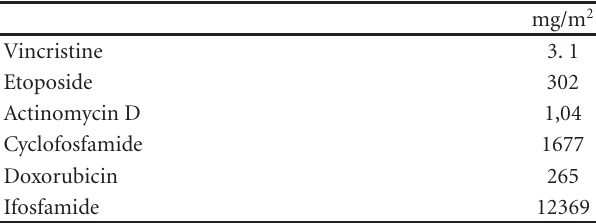
Figure 3: Immunohistochemical analysis shows uniform, strong positive staining for